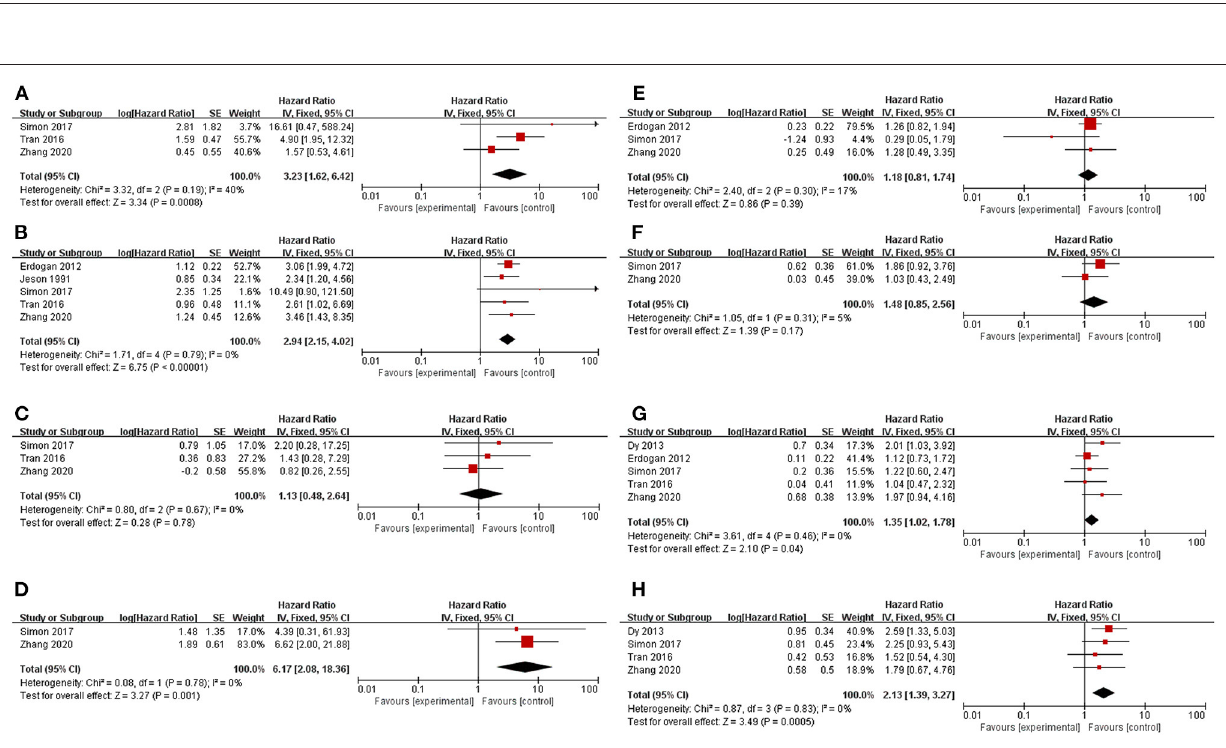
Frontiers in Surgery |